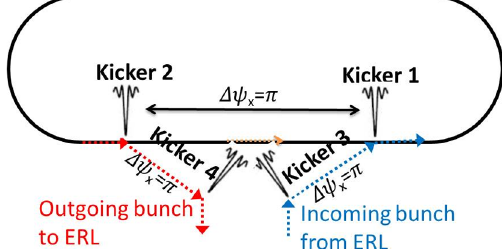
FIG. 9. Compensation scheme for the nonuniform kicking pulse by using identical predistortion kicker (Kicker 3) and postdistortion kicker (Kicker 4).